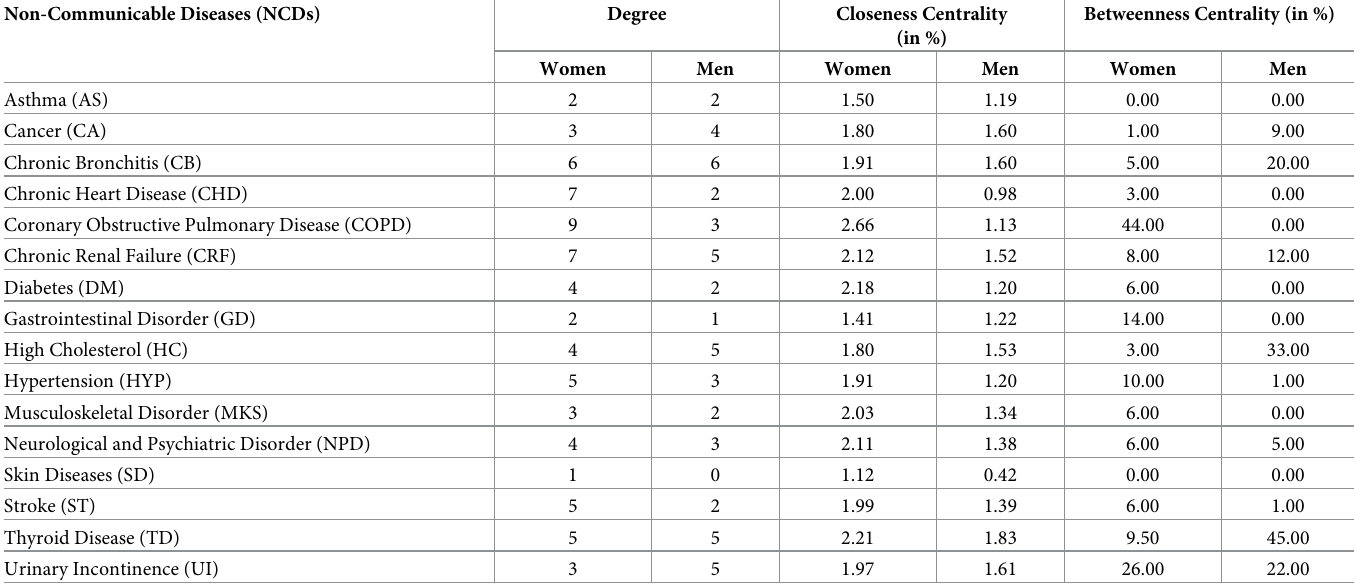
Table 3. Node specific centrality measures by gender in the older adult population with multimorbidity, Longitudinal Ageing Study in India,